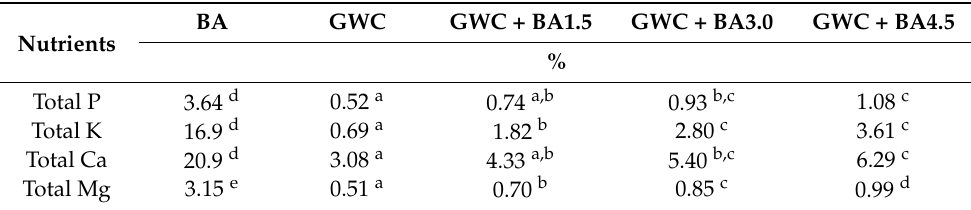
Table 2. Chemical composition of the major nutrients (P, K, Ca, and Mg) in BA and complex composted materials (%). BA GWC GWC + BA1.5 Nutrients